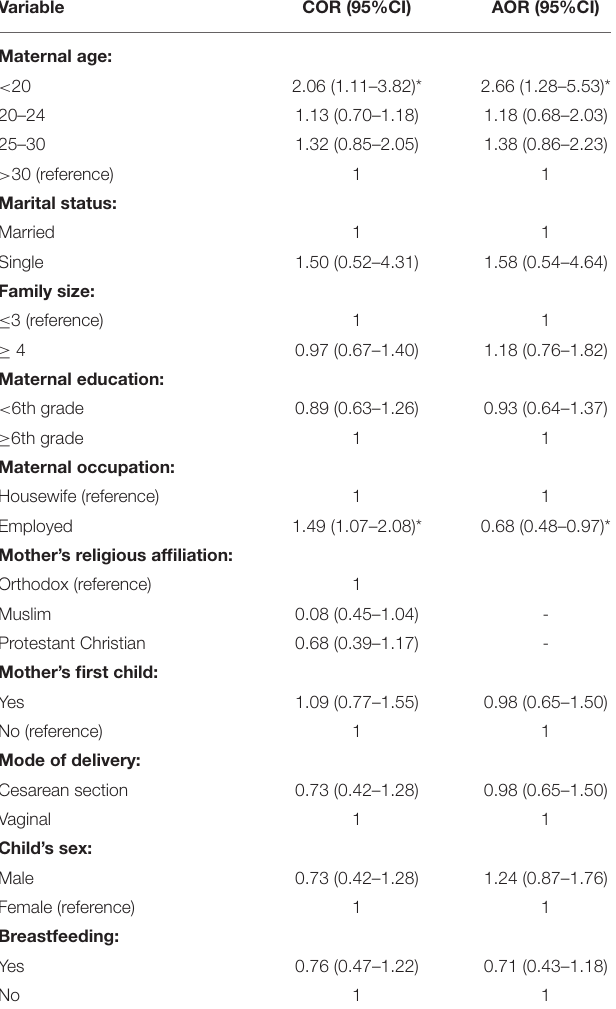
TABLE 2 | Multivariable logistic regression analysis of factors associated with the initiation of CF at 6 months of participating children. Variable